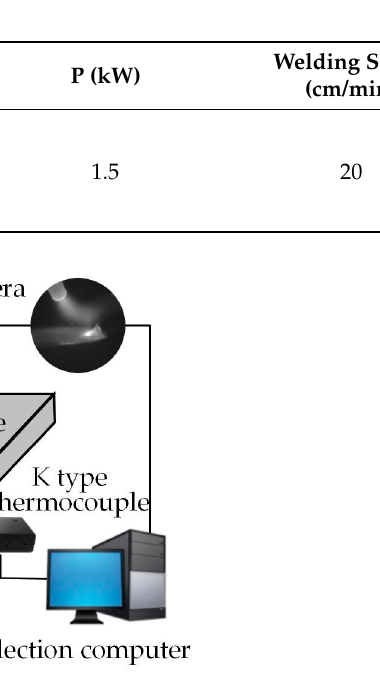
Figure 2. Laser–TIG hybrid welding system: ( a ) physical picture; ( b ) position relation of the laser, TIG torch, and welding wire.